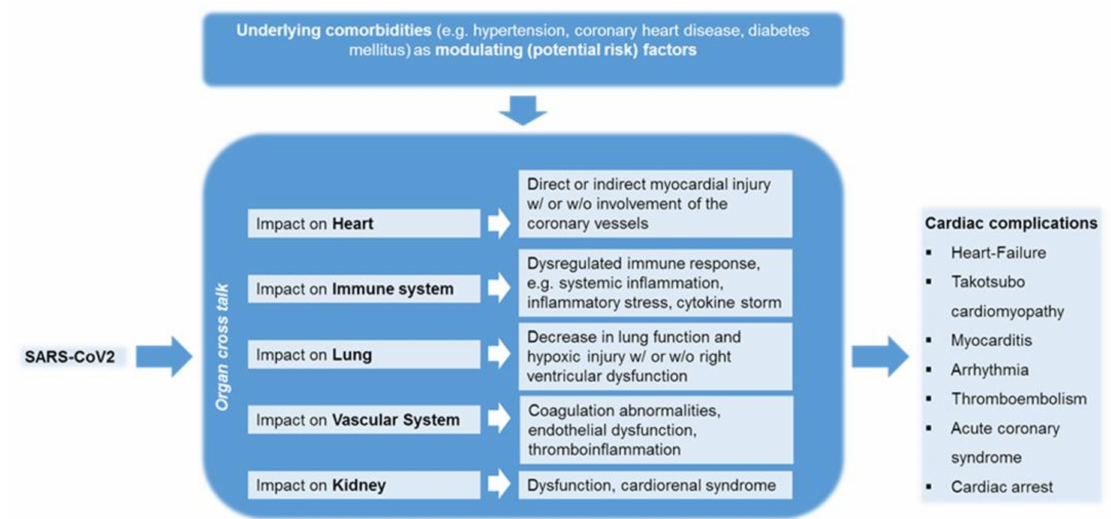
Figure 3. A crosstalk between the organs in inducing cardiac complications that are primarily triggered by SARS-CoV-2 virus among patients with underlying chronic